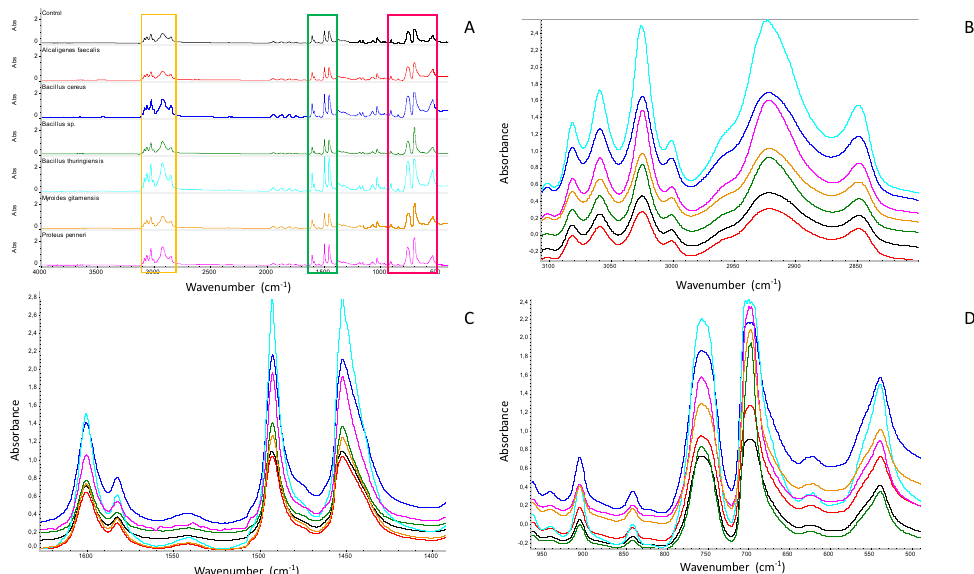
Figure 4. FTIR spectra of mechanically crushed spheres of polystyrene (PS). ( A ) Spectra from polymers without inoculum (control) and with each one being bacteria inoculated; ( B ) Detail of spectra in vibration band between 3100 and 2500 cm − 1 ; ( C ) Detail of spectra in vibration band between 1600 and 1000 cm − 1 ; ( D ) Detail of spectra in vibration band between 1100 and 750 cm − 1 . Red line corresponds to PS mechanically crushed spheres inoculated with Alcaligenes faecalis , blue line with Bacillus cereus , green line with Bacillus sp., light blue line with Bacillus thuringiensis , orange line with Myroides gitamensis , pink line with Proteus penneri and black line corresponds to PP spheres without inoculum (control).